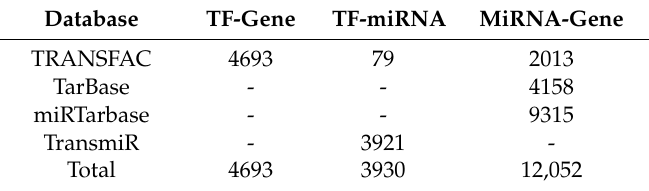
Table 2. Statistics of the regulations in the integrated TF-miRNA regulatory network. Database TF-Gene TF-miRNA MiRNA-Gene TRANSFAC 4693 79 2013 TarBase - - 4158 miRTarbase -